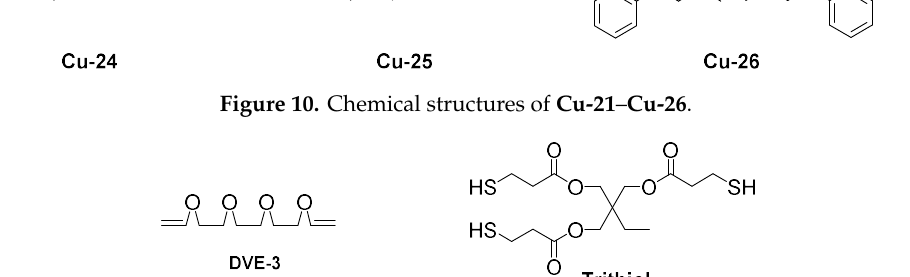
Figure 11. Chemical structures of monomers used for the thiol-ene reaction with Cu-18 .